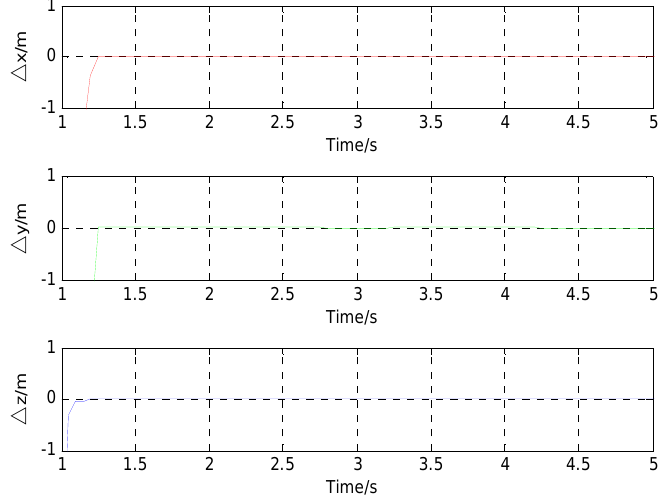
Figure 7. Difference between locating results and actual value in three direction.